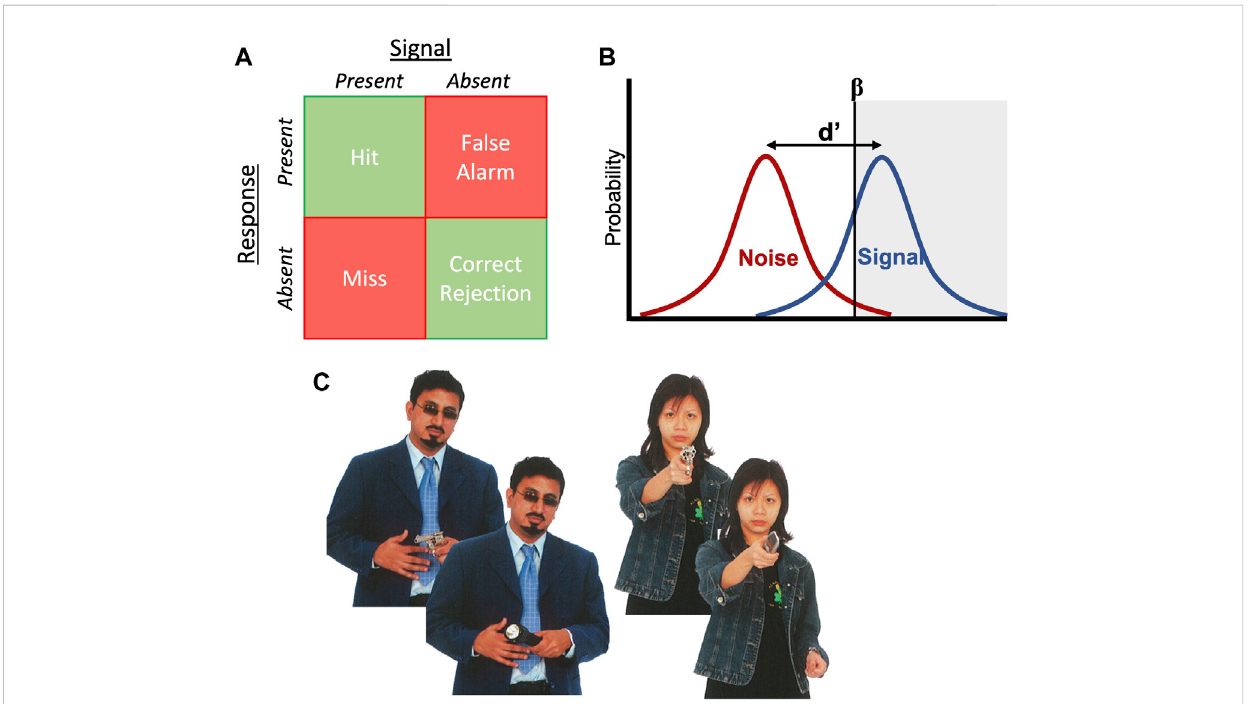
FIGURE 3 Illustration of Signal Detection Theory. The matrix in (A) shows four possible combinations of signals and responses. (B) illustrates the metrics d-primeandbetainrelationtodistributionsofsignal(weapon presentorabsent)and noise.Asdrawnhere, d-primewouldbelargebecausetheobserver was able to perceive a clear difference between the signal and the noise. The beta value is to the right indicating a conservative response strategy. (C) shows examples of the Sykes-McQueen “ 8,000 range ” threat assessment targets used in the synthetic and VR environments. Reproduced with